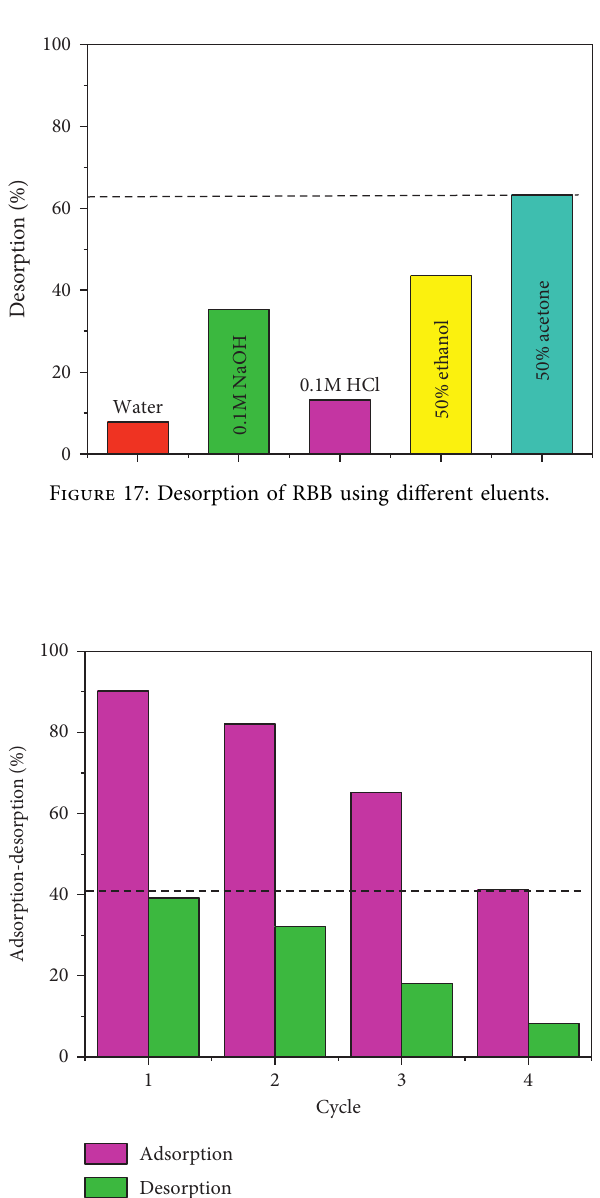
Figure 18: Desorption of RBB using 50% acetone after 4 cycles.